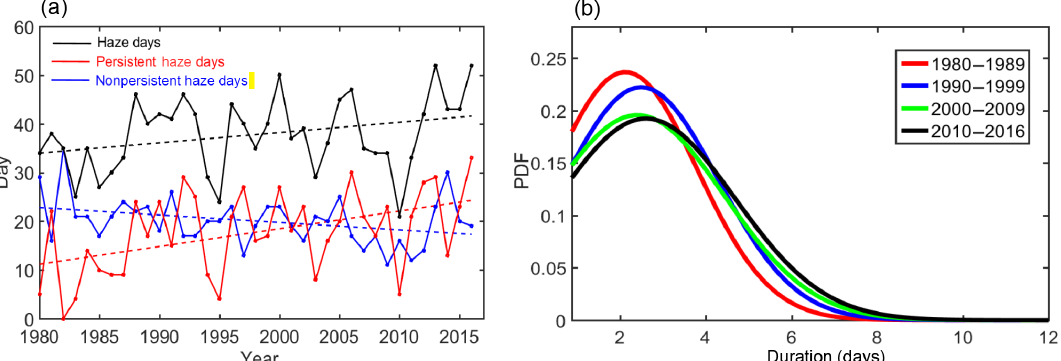
Figure 2. (a) Number of haze days (black), persistent haze days (red) and nonpersistent haze days (blue) in winter in Beijing from 1980 to 2016. Dashed lines show the least-squares trends. (b) Probability distribution function (PDF) of the duration (days) of haze events in Beijing for each decadal period from 1980 to